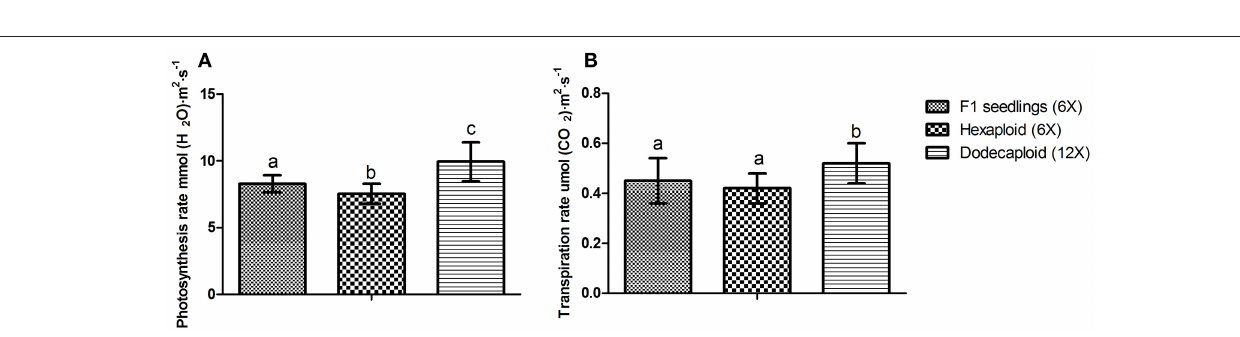
TABLE 1 | The numbers of DGE transcripts of 6 comparisons between each two samples are shown.